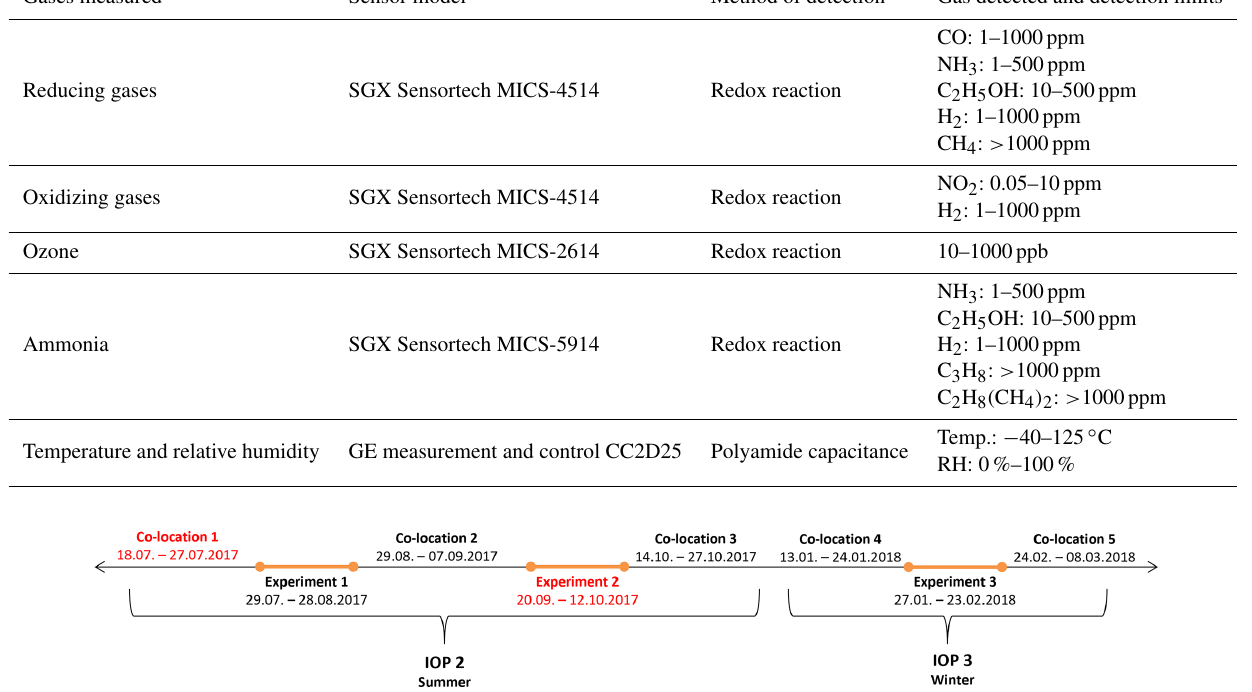
Table 1. Sensors installed within the EarthSense Zephyr prototypes. Table reproduced from Peterson et al. (2017). Gases measured